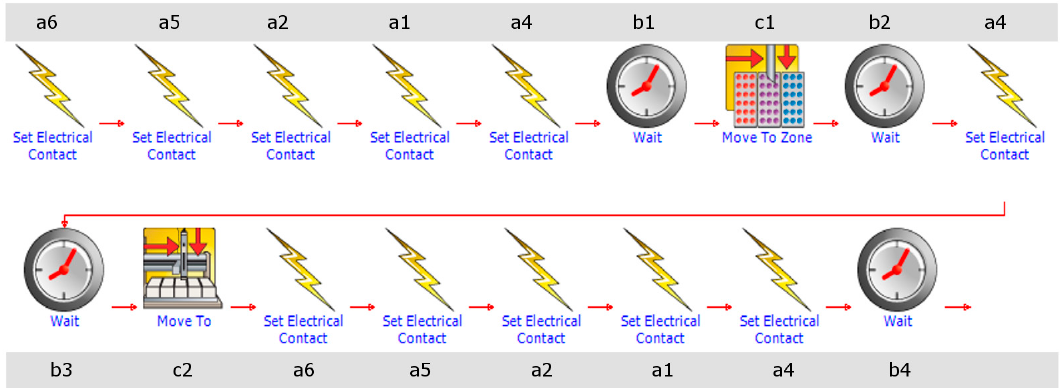
Figure 4. A schematic circuit diagram of the offline system (Gilson Sampler GX-271;